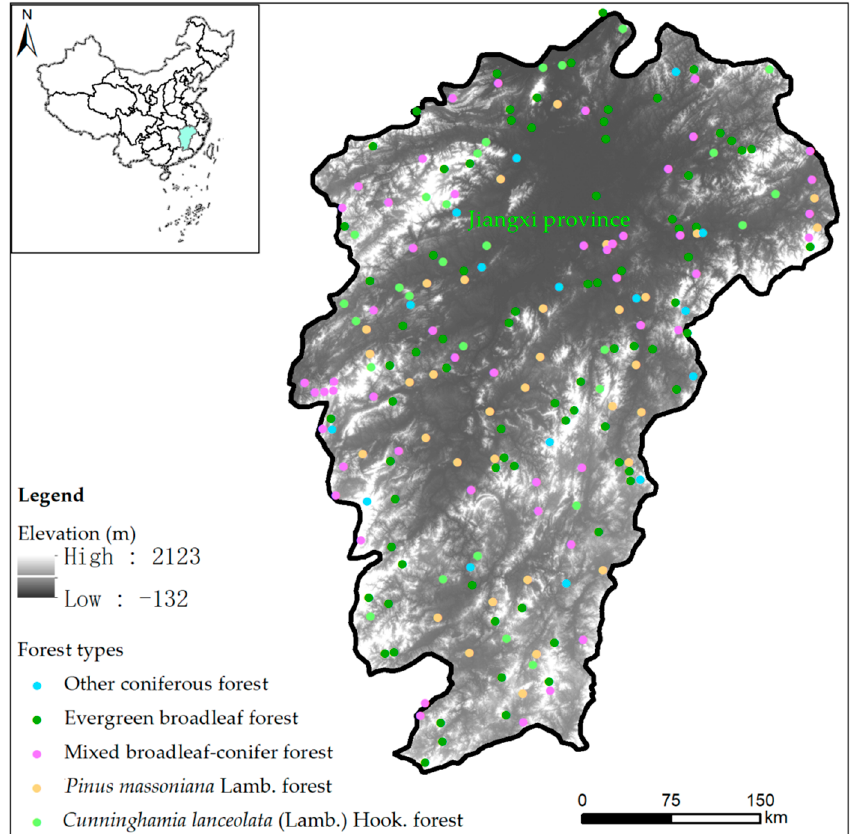
Figure 1. Distribution of forest continuous inventory sample plots on the topographical map of Jiangxi province .